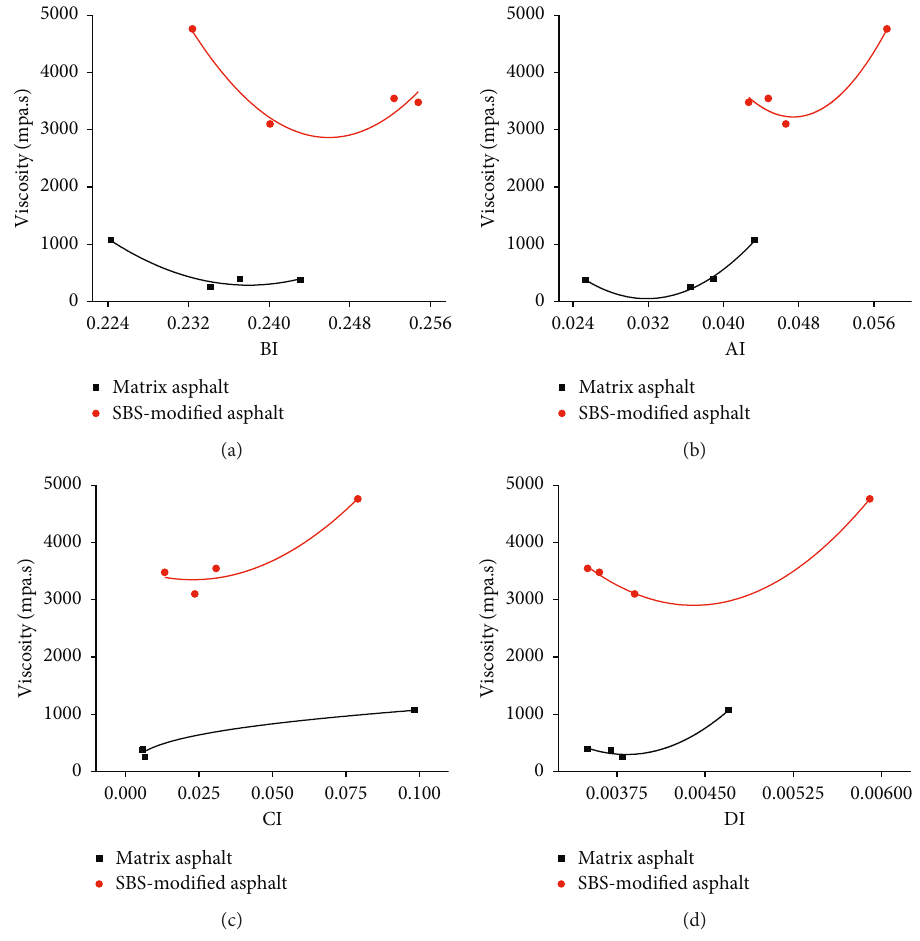
Figure 19: Relationships between various functional group indices and viscosity.